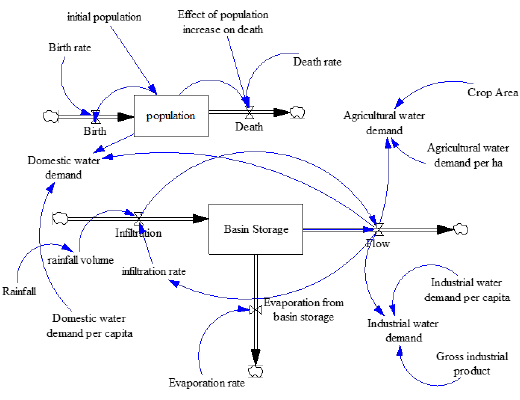
Figure 3. Stock-Flow Diagram of the population